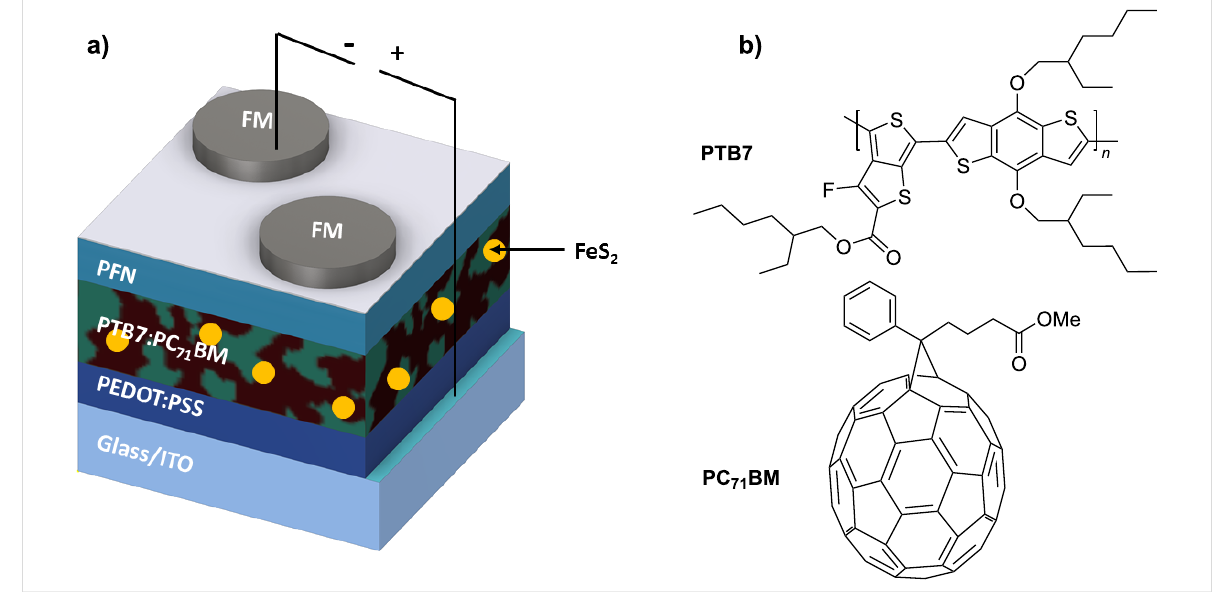
Figure 1: a) OPV structure. FM: Field’s metal (Bi, In, Sn); b) Chemical structure of PTB7 and PC 71 BM.